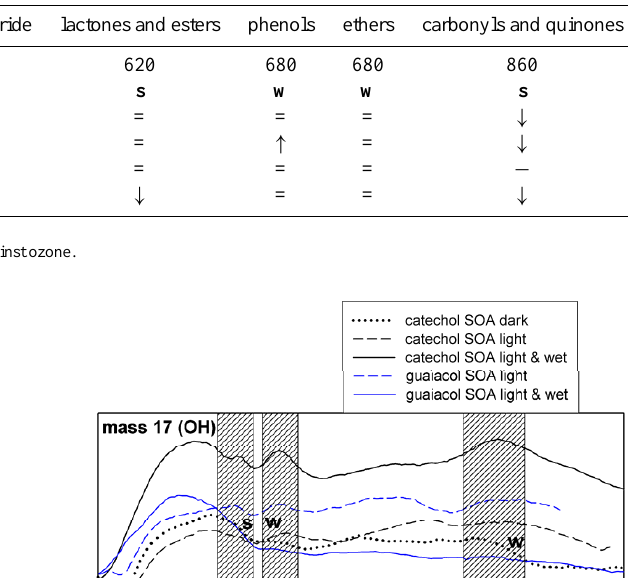
Table 3. Maxima of observed decomposition temperatures [ ◦ C] of functional groups in a sample of catechol SOA dark (bold face, s = strong, w = weak) and comparison with the other conditions (light, light and wet) and precursor ∗ , leading to the categories increased ( ↑ ) , equal (=), decreased ( ↓ ) and not observed ( − ) for the functional groups.